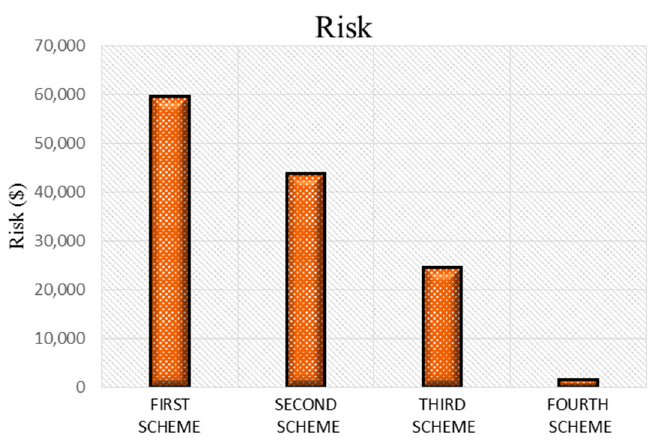
Figure 12. Amount of Risk under different scheme with the average selling price of 63 $/MWh.